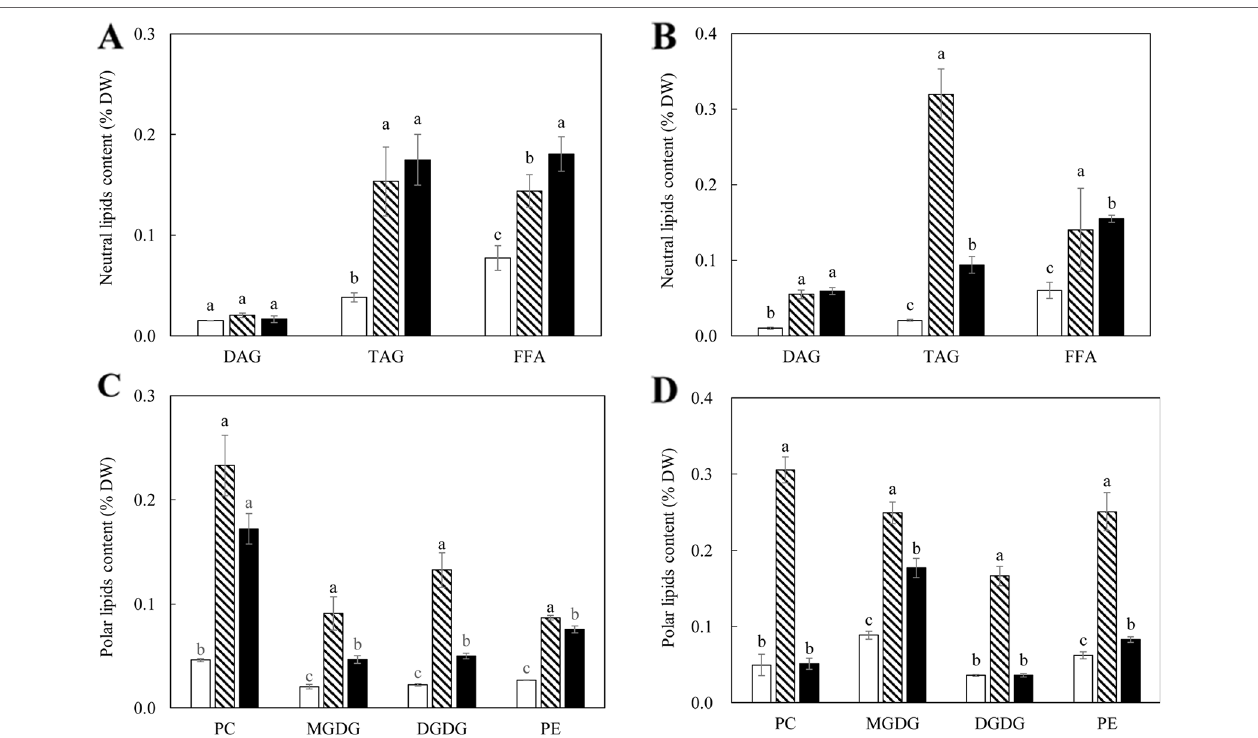
FigURE 3 | Contents of neutral and polar lipids in the potato tubers of WT (open bars) and the two selected WT-derived lines, WT-L5 (hatched bars) and WT-L10 (black bars) at two developmental stages. (A) Neutral lipids contents at the flowering stage; (B) Neutral lipids contents at the mature stage; (c) Polar lipids contents at the flowering stage; (D) Polar lipids contents at the mature stage. The data represent the mean values ± SD of three biological replicates. Letters (a, b, c) above the bars are based on LSD, bars marked with different letters are statistically significantly different at P <